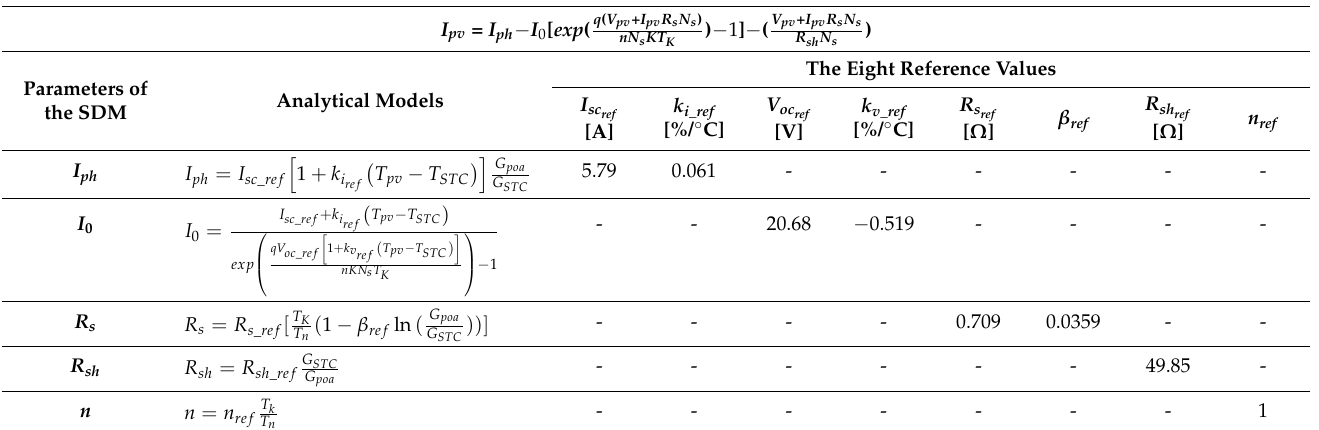
Table 11. Summary of the eight reference values extracted from the analytical models.